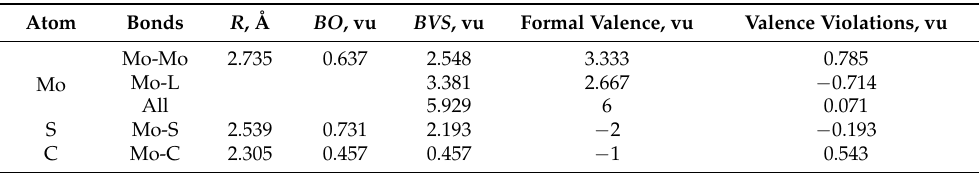
Table 3. BV analysis based on the data of Ref.